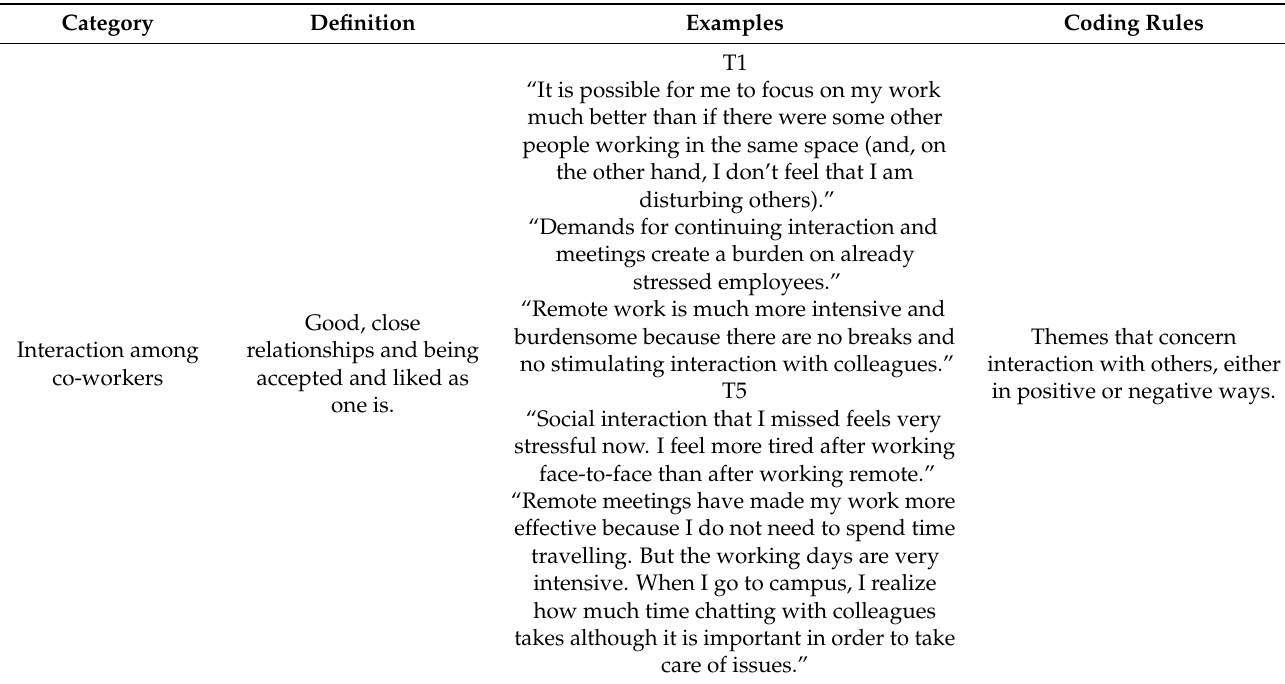
Table 1. Interaction affecting the experience of relatedness at remote